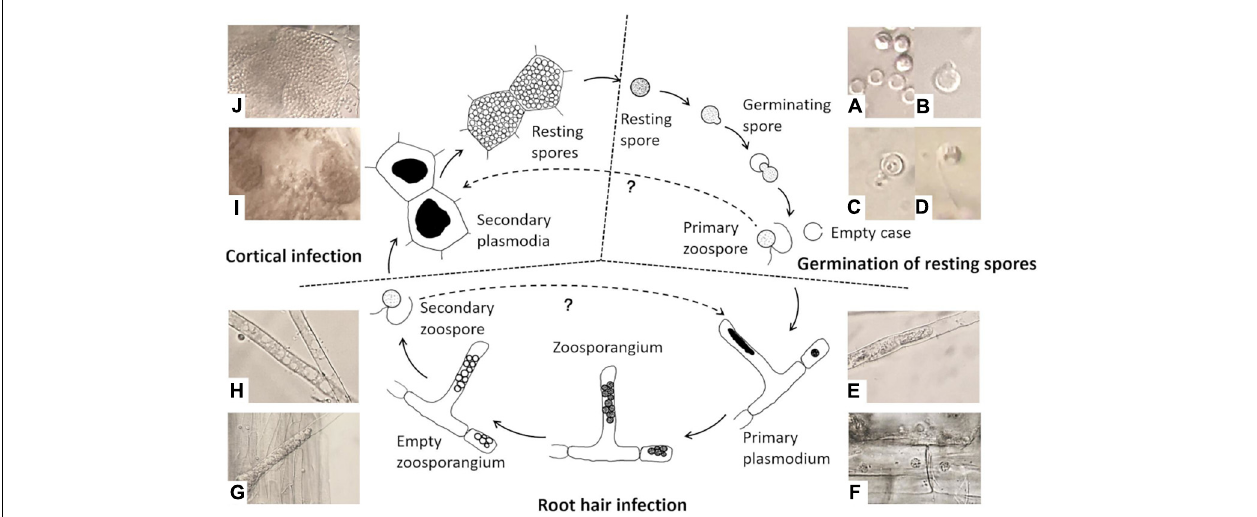
FIGURE 1 | Life cycle of Plasmodiophora brassicae . (A) Resting spores (full) and germinated spores (empty); (B) emerged “papilla”; (C) germinating spore; (D) primary zoospore; (E) primary plasmodium in root hair; (F) primary plasmodium in epidermal cells; (G) zoosporangial cluster in root hair; (H) empty zoosporangium; (I) secondary plasmodia in cortical cells; (J) resting spores in cortical cells.